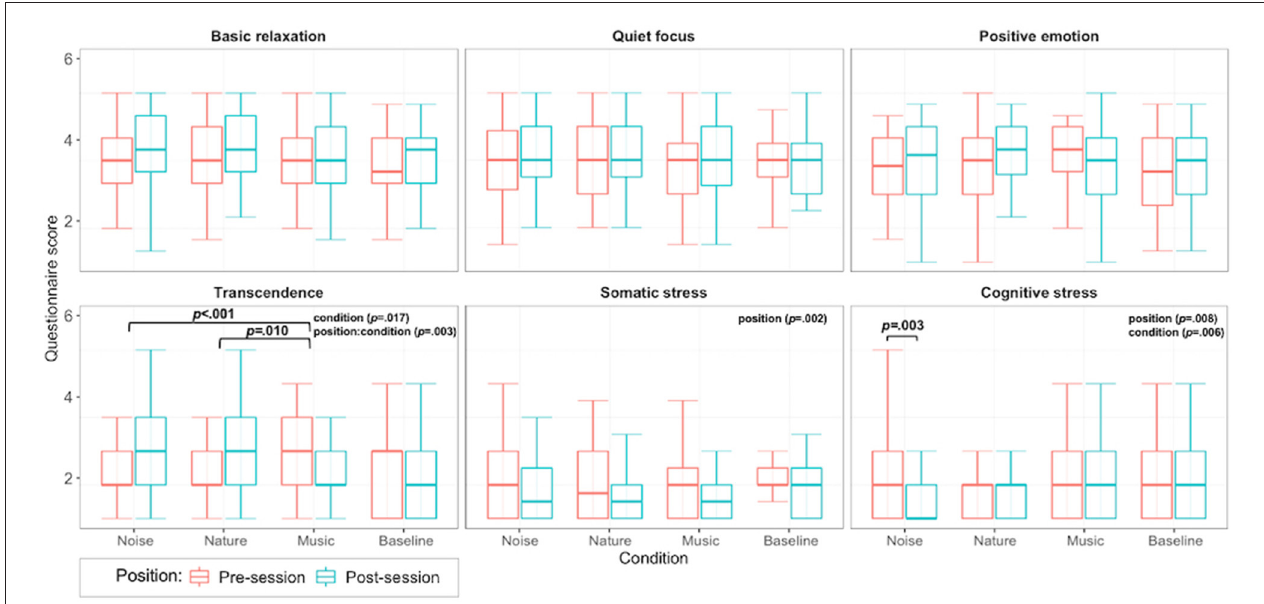
FIGURE 2 | Boxplot of relaxation questionnaire data [subcategories taken from Smith (2001)].